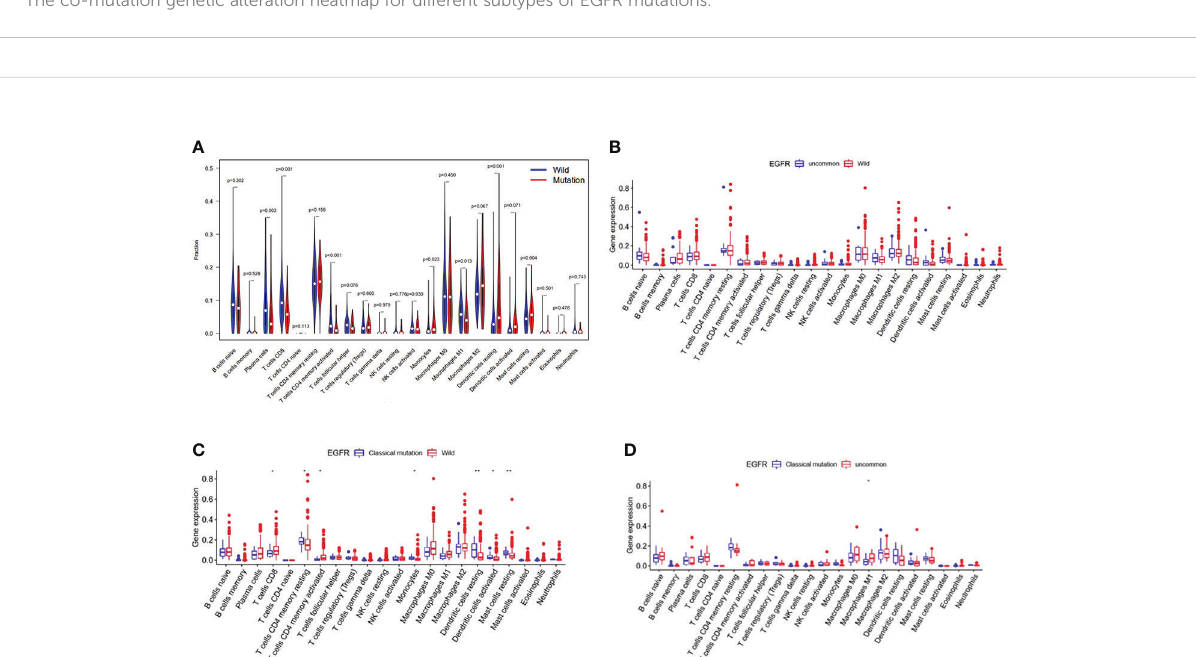
FIGURE 5 Immune cell in fi ltration in TCGA database. Comparison of immune cells in NSCLC patients from TCGA database between EGFR wild-type and EGFR-mutated groups (A) , EGFR uncommon mutations and EGFR wild-type groups (B) , EGFR classical mutations and EGFR wild-type groups (C) , and EGFR classical mutations and uncommon mutations (D)